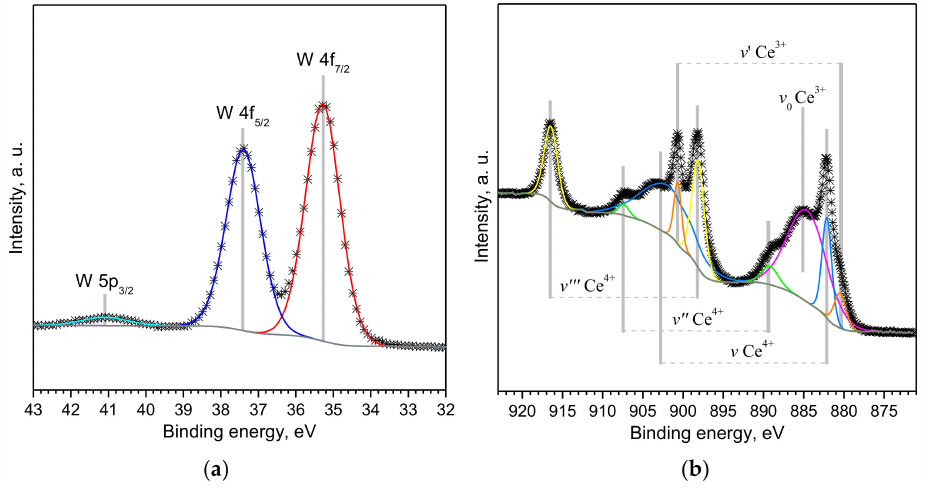
Figure 5. ( a ) The W 4f and ( b ) Ce 3d spectra recorded on the cerium-modified wires. The W 4f spectrum recorded on the non-modified tungsten oxide wires showed similar